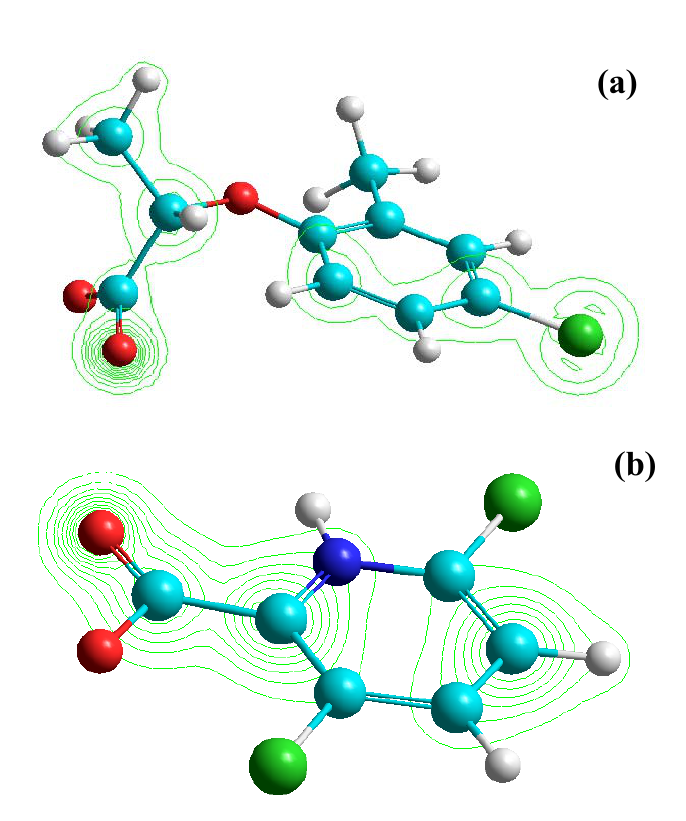
Figure 10. TCD maps for the herbicide molecules: mecoprop (a) and clopyralid (b). TCD contours are shown in green lines, C atoms - cyan, H atoms - white, O atoms - red, Cl atoms - green and N atom -